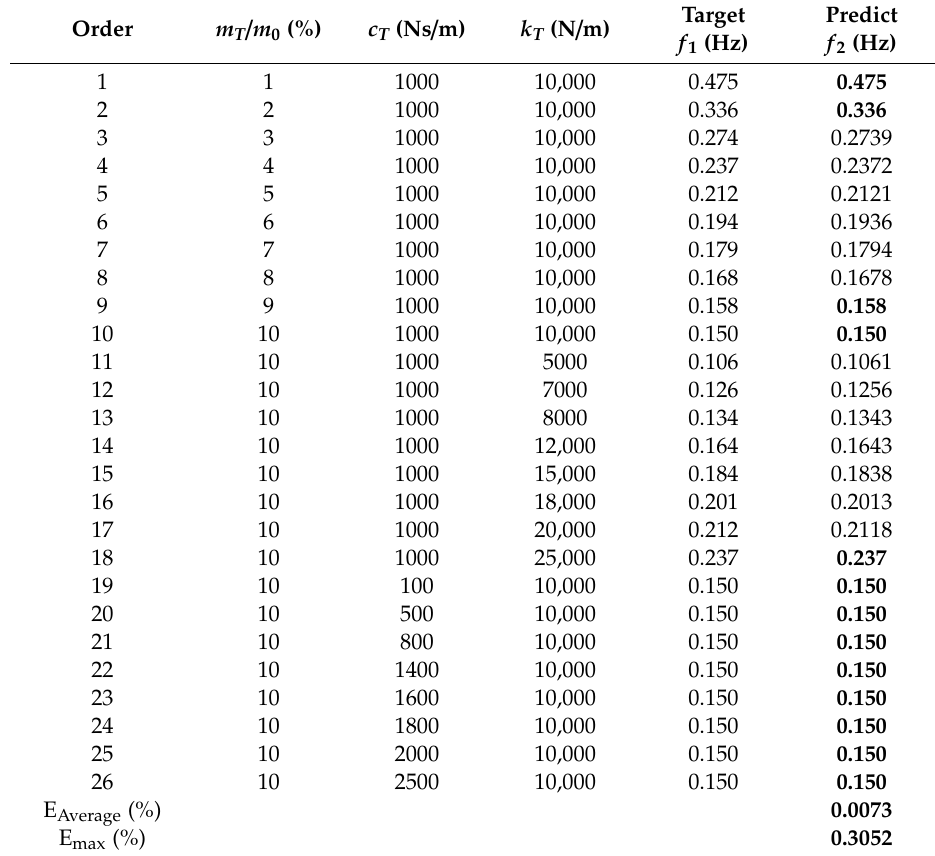
Table 12. The input and output parameters of this ANN model for the space frame system with one